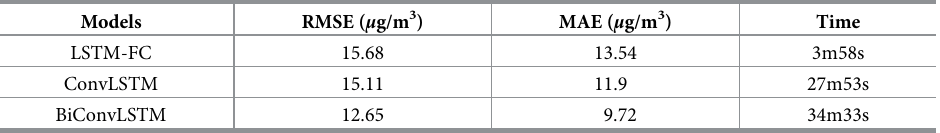
Table 6. Prediction errors (RMSE, MAE) and runtime of the models for the next 6 hours prediction implemented on the selected